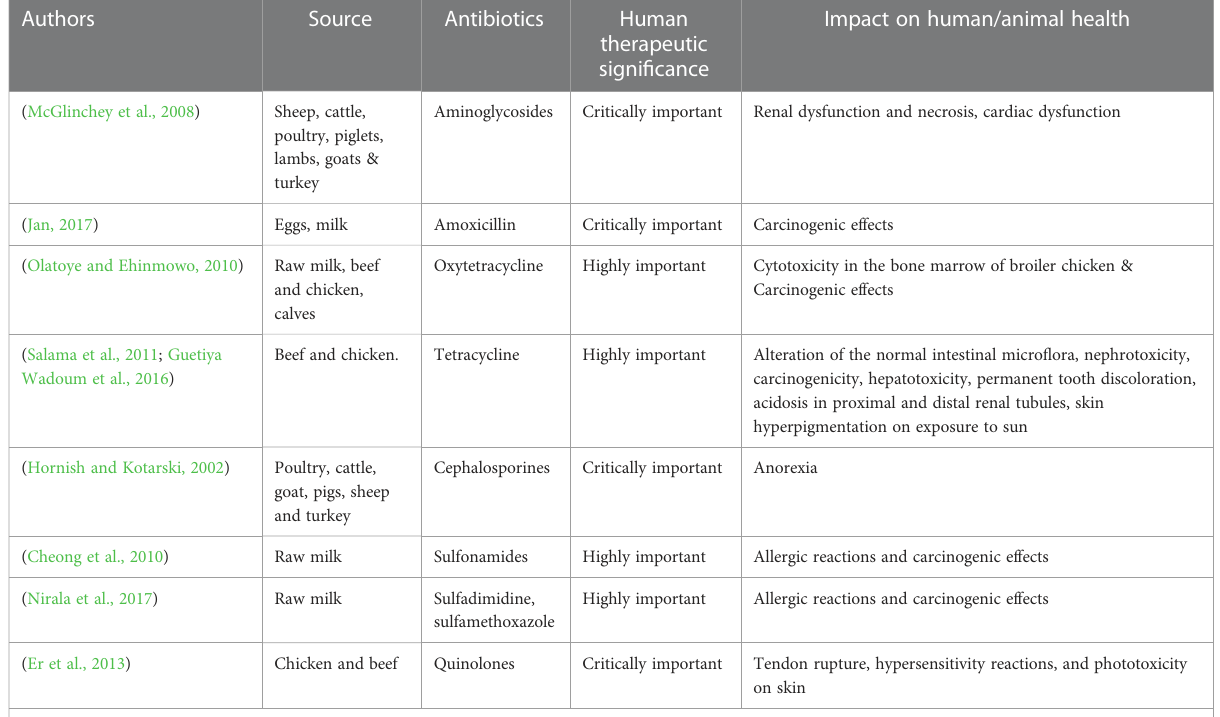
TABLE 4 Impact of some of the common antibiotics on human/animal health*